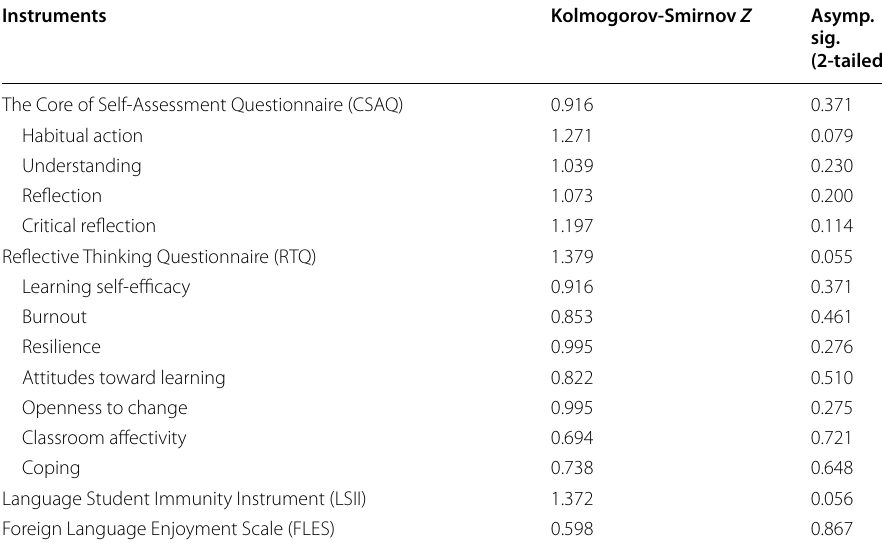
Table 2 The results of Kolmogorov-Smirnov